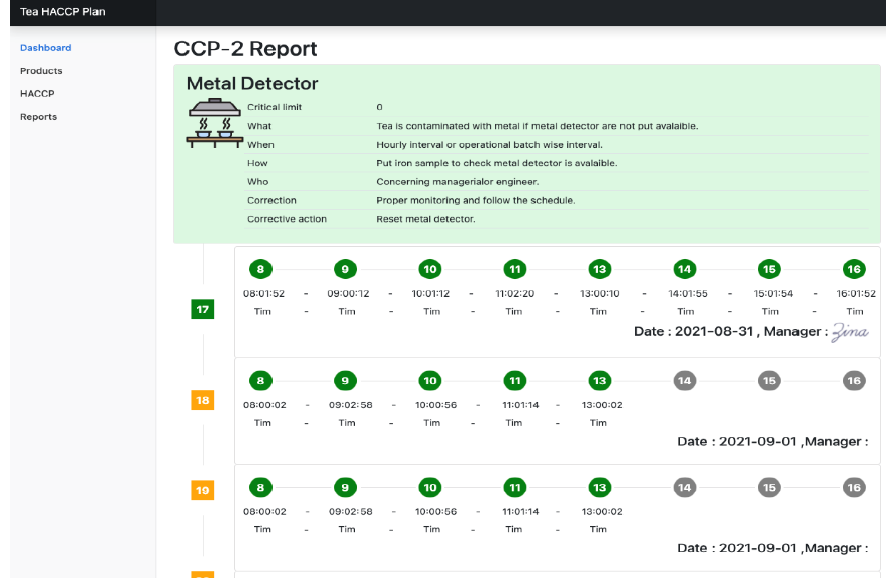
Figure 17. The system implementation of CCP reports for each batch.